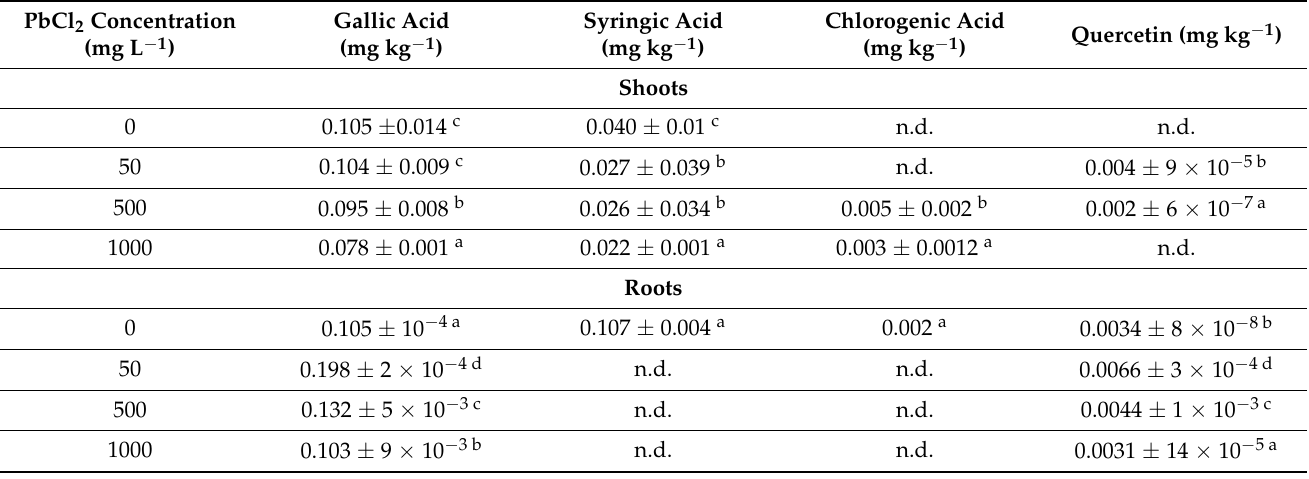
Table 2. Effects of PbCl 2 treatment (0, 50, 500 and 1000 mg L − 1 ) on phenolic compound concentrations. All the values are means of triplicates ± SD. ANOVA is significant at p < 0.05. Different letters indicate significantly different values at particular lead concentrations (DMRT, p <